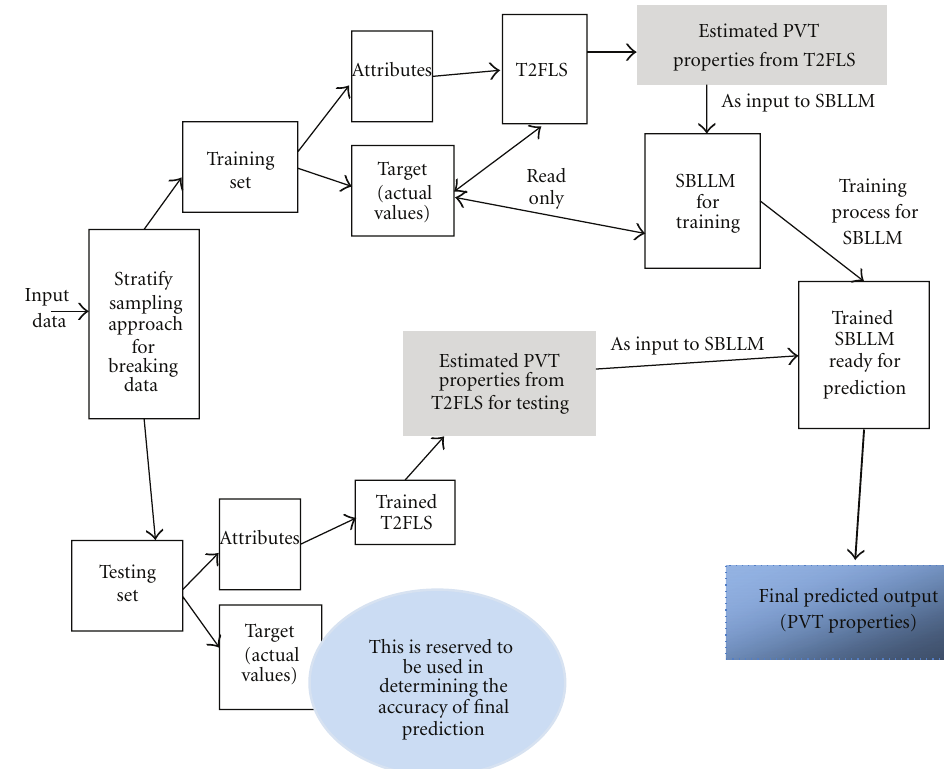
Figure 6: Data flow diagram of the proposed T2-SBLLM hybrid model.